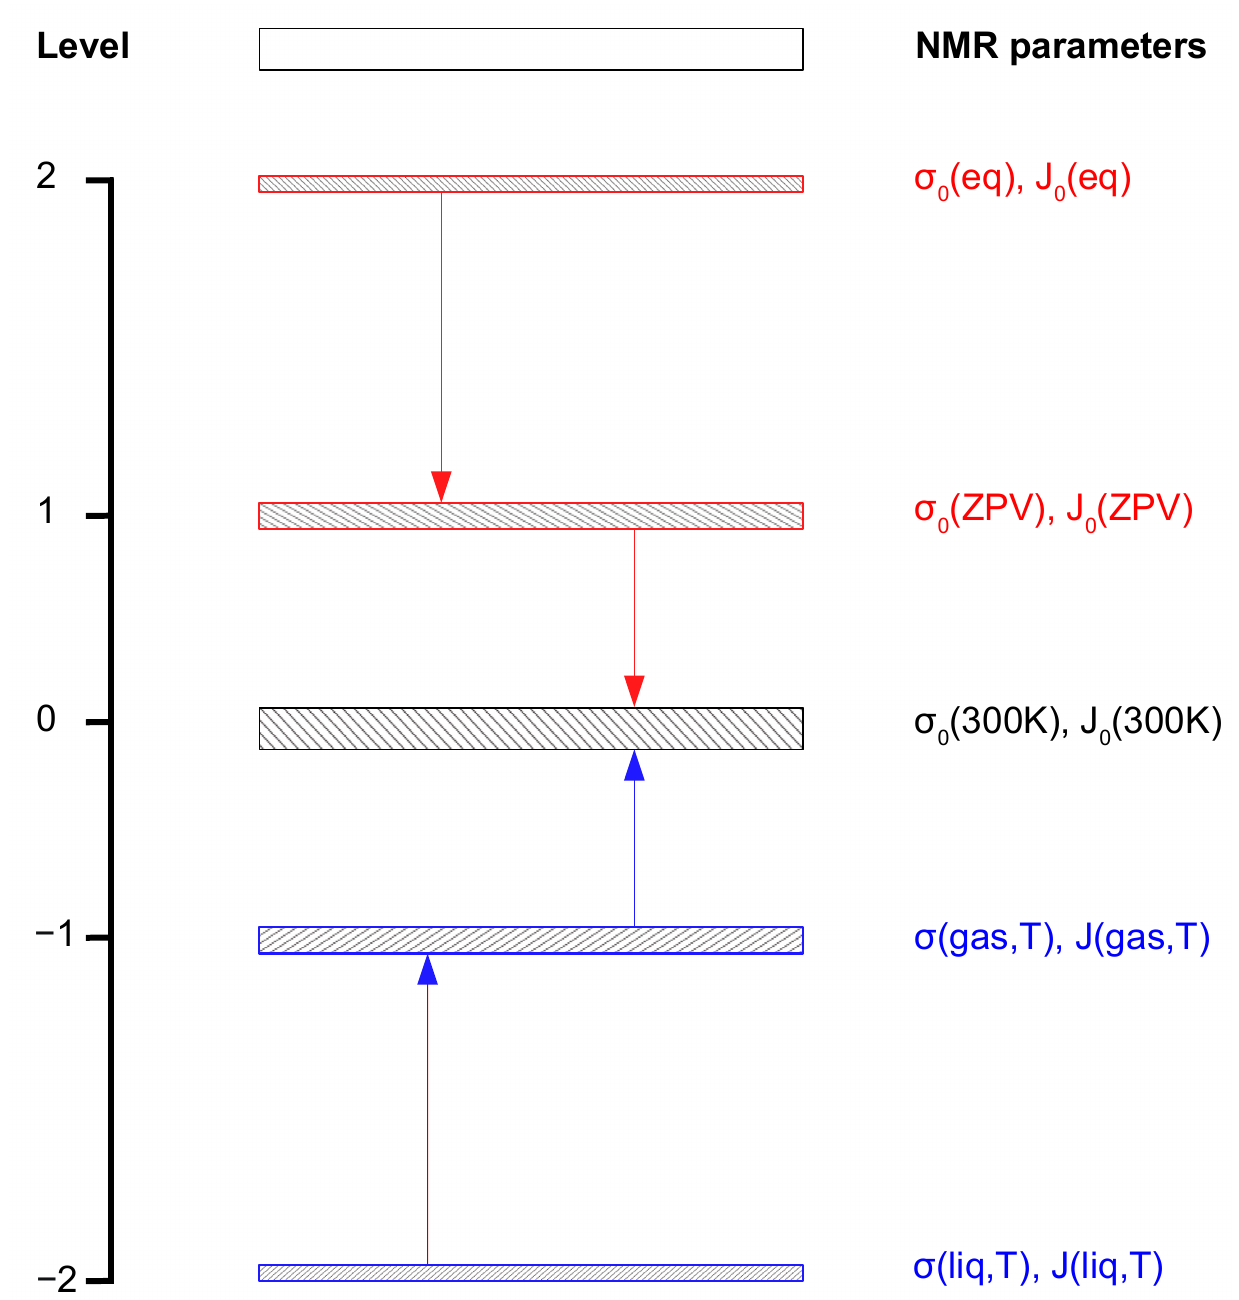
Figure 1. Comparison of experimental and calculated NMR spectral parameters σ and nJ. The thickness of Levels illustrates the increasing uncertainty of determining parameters from − 2 to 0 for experiments and from 2 to 0 for calculations.